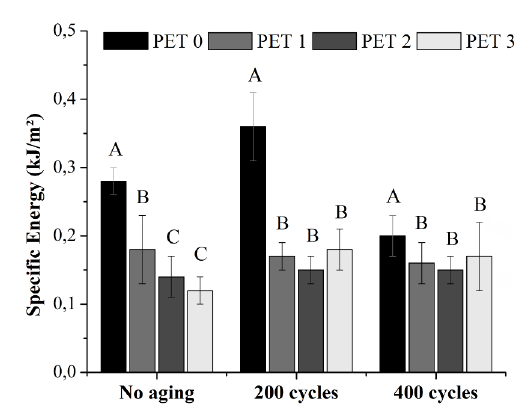
Figure 7. Average and standard deviation values of modulus of elasticity of fiber cement produced with PET particles. Consecutive means of the same letter do not statistically differ by the Scott-Knott mean test, at 5% of significance. PET1= 20 to 24 mesh, PET2= 24 to 32 mesh and PET3 = 32 to 35 mesh.